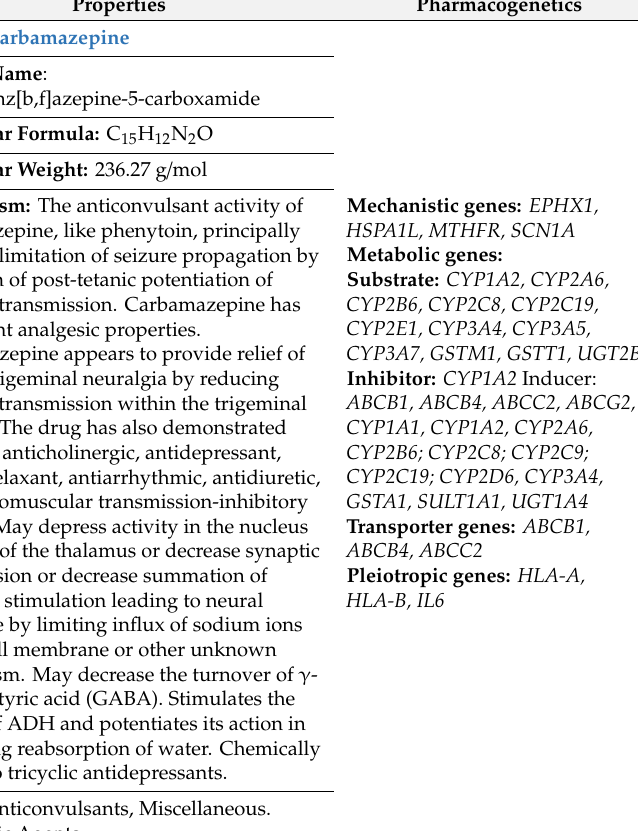
Table 6. Pharmacological properties and pharmacogenetics of selected antiepileptic